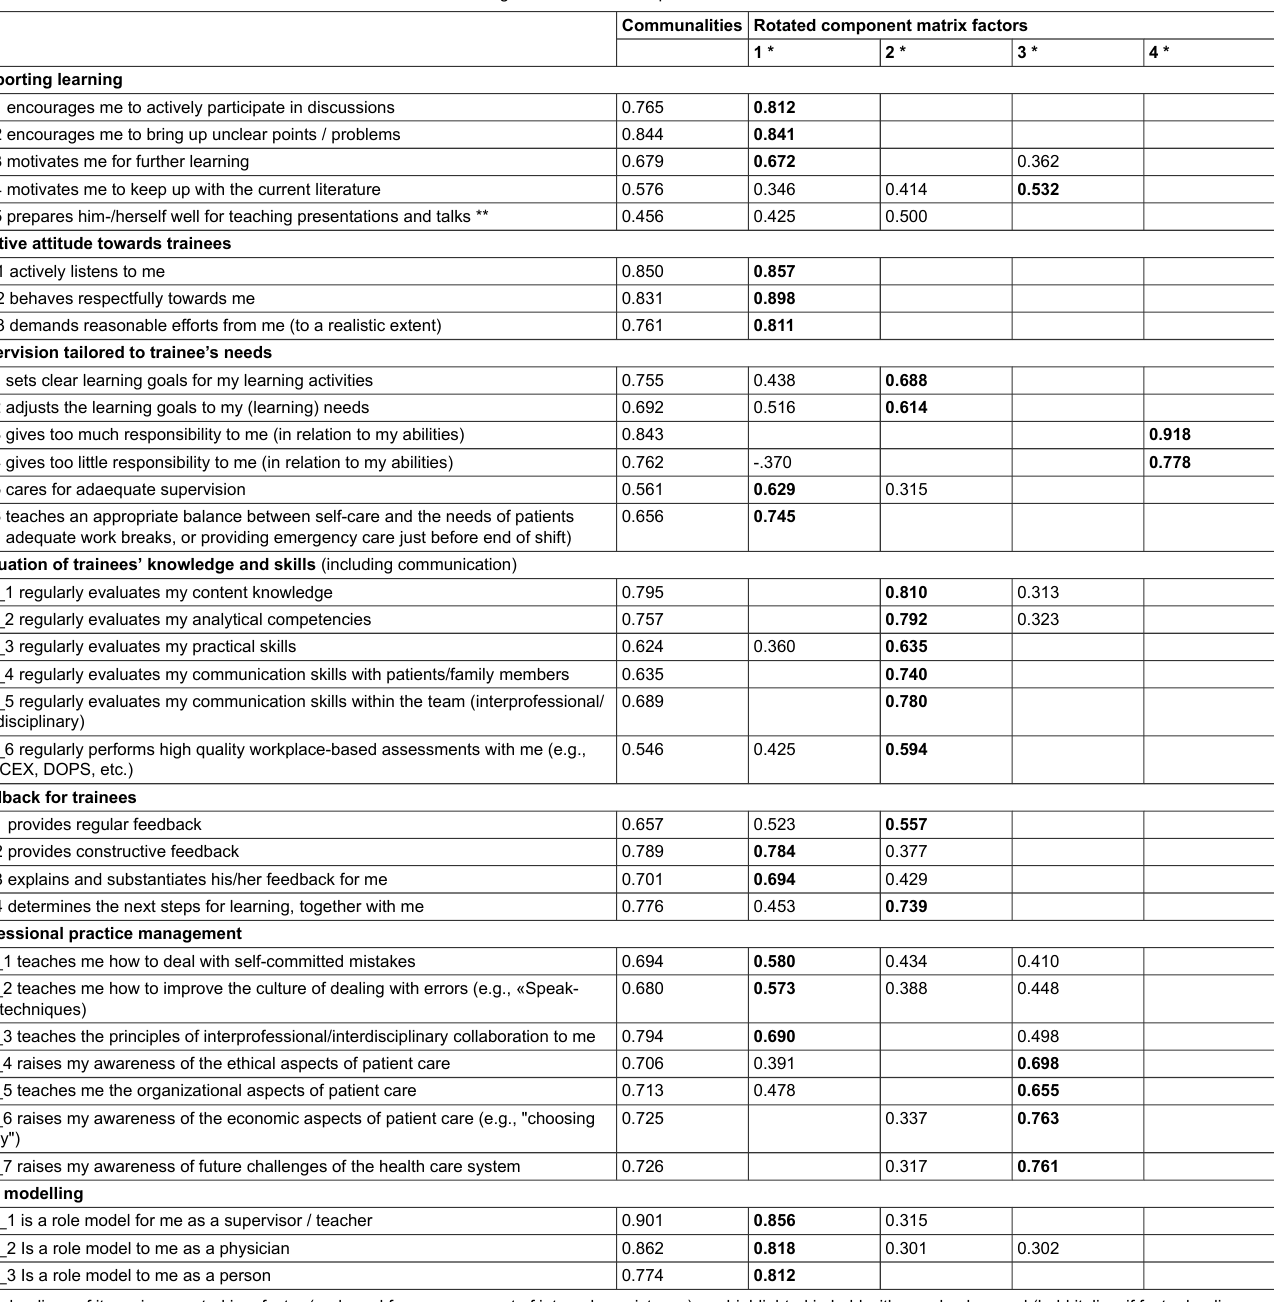
Table 2: Items of the SwissSETQ instrument with communalities and factor loadings of the rotated component matrix.